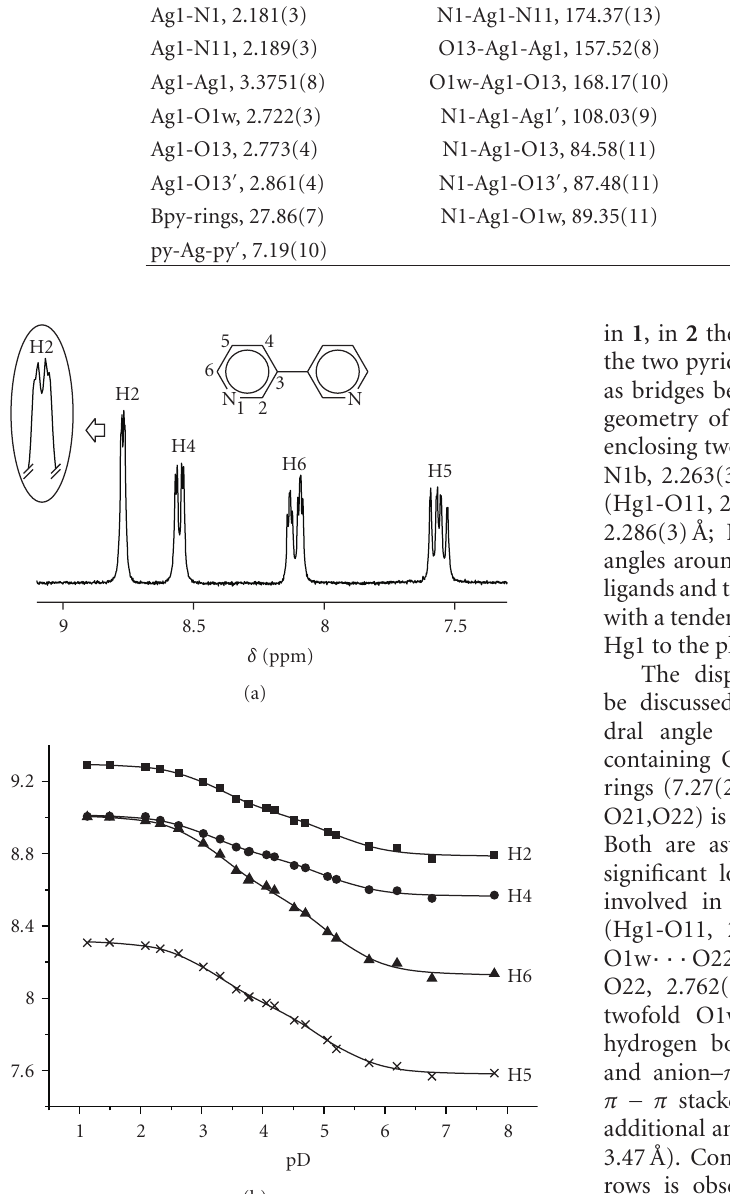
Each O1w forms two hydrogen bonds with two